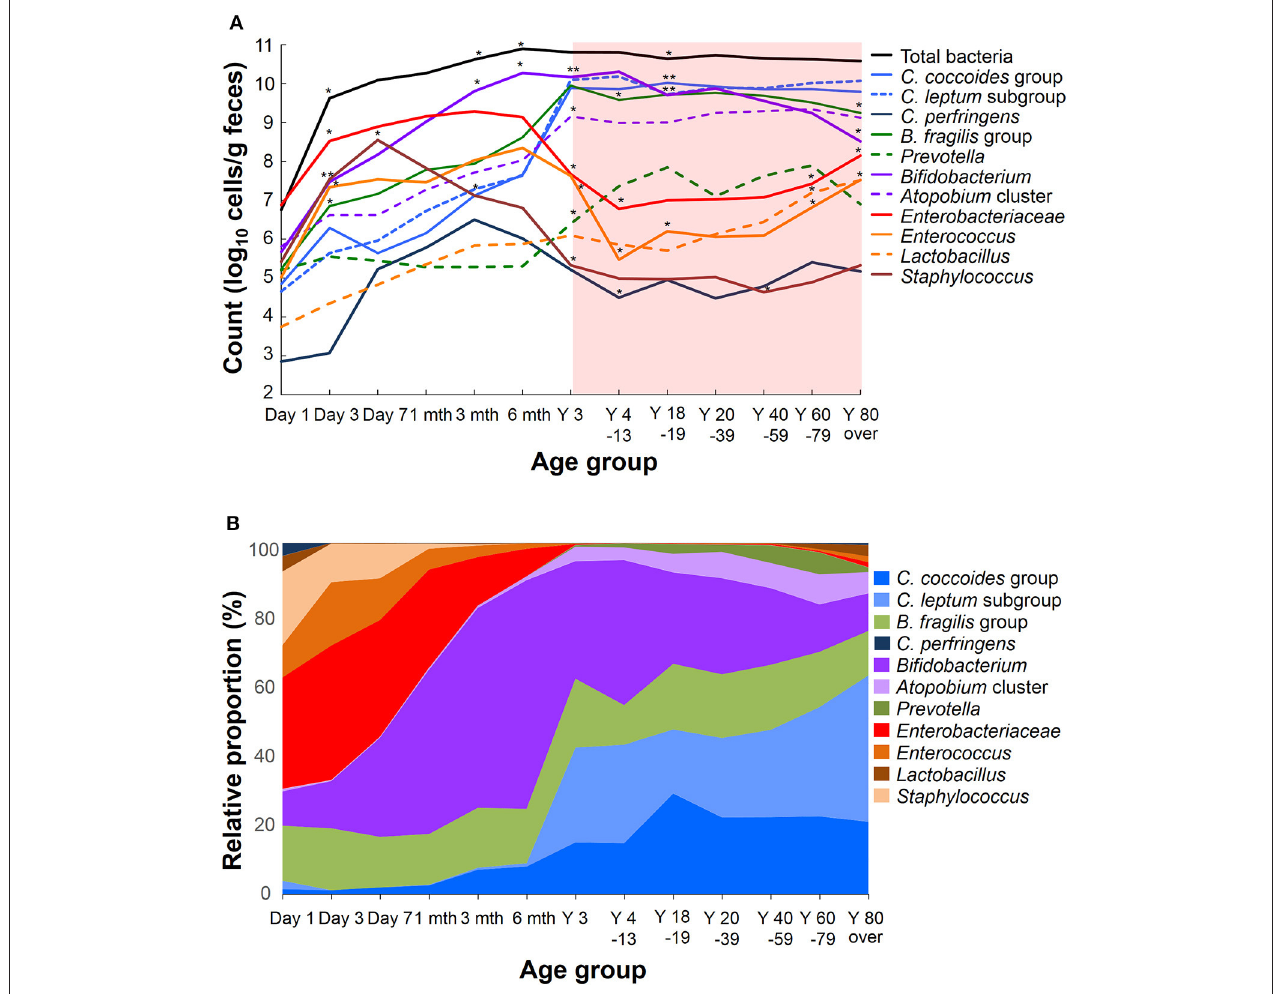
FIGURE 1 | Age-related differences in average counts (A) and relative proportions (B) of intestinal bacteria in healthy Japanese volunteers ( n = 1951). An asterisk shows the significant difference between the count of a period and the preceding one ( A , Steel-Dwass multiple comparison test, * P < 0.05, ** P <